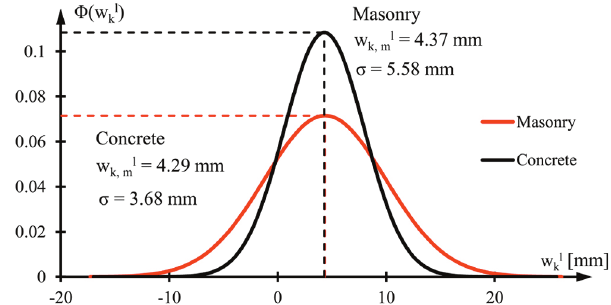
Fig. 23. Probability distribution of limit slip for specimens